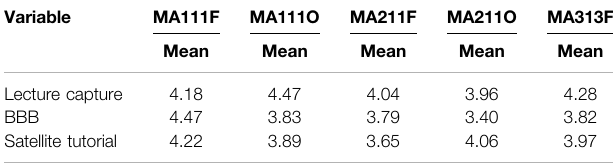
TABLE 6 | Students ’ perspective on the selected ATs commonly used at USP. Variable